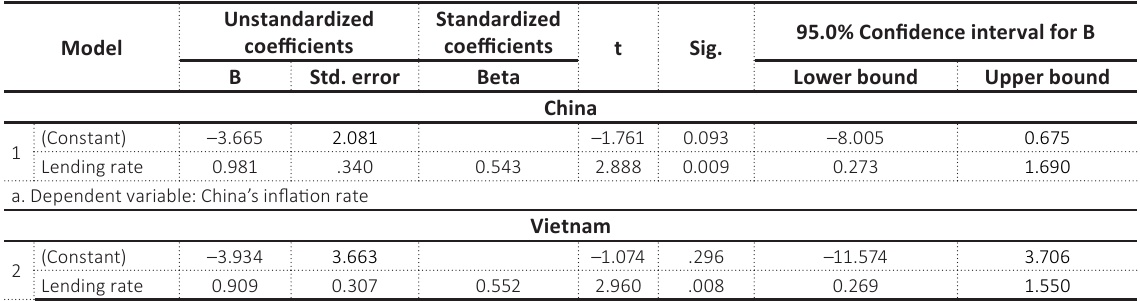
Table 9. China’s and Vietnam’s coefficients a of inflation and lending